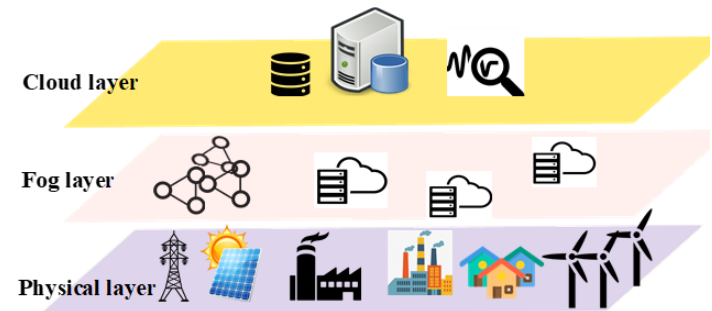
Figure 5. The general architecture of the system.